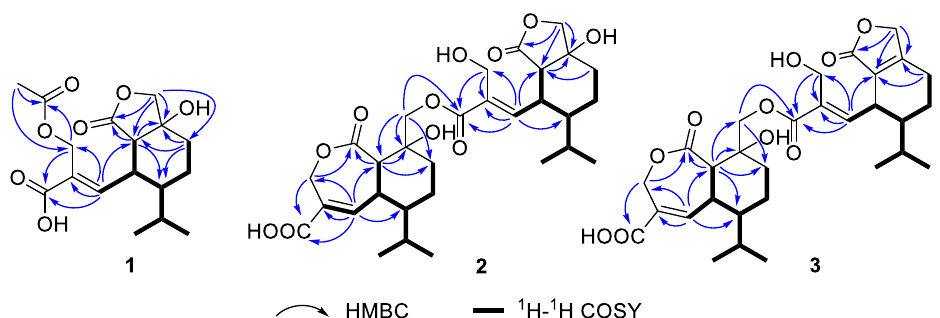
Fig. 2 Key HMBC and 1 H– 1 H COSY correlations of compounds 1 –